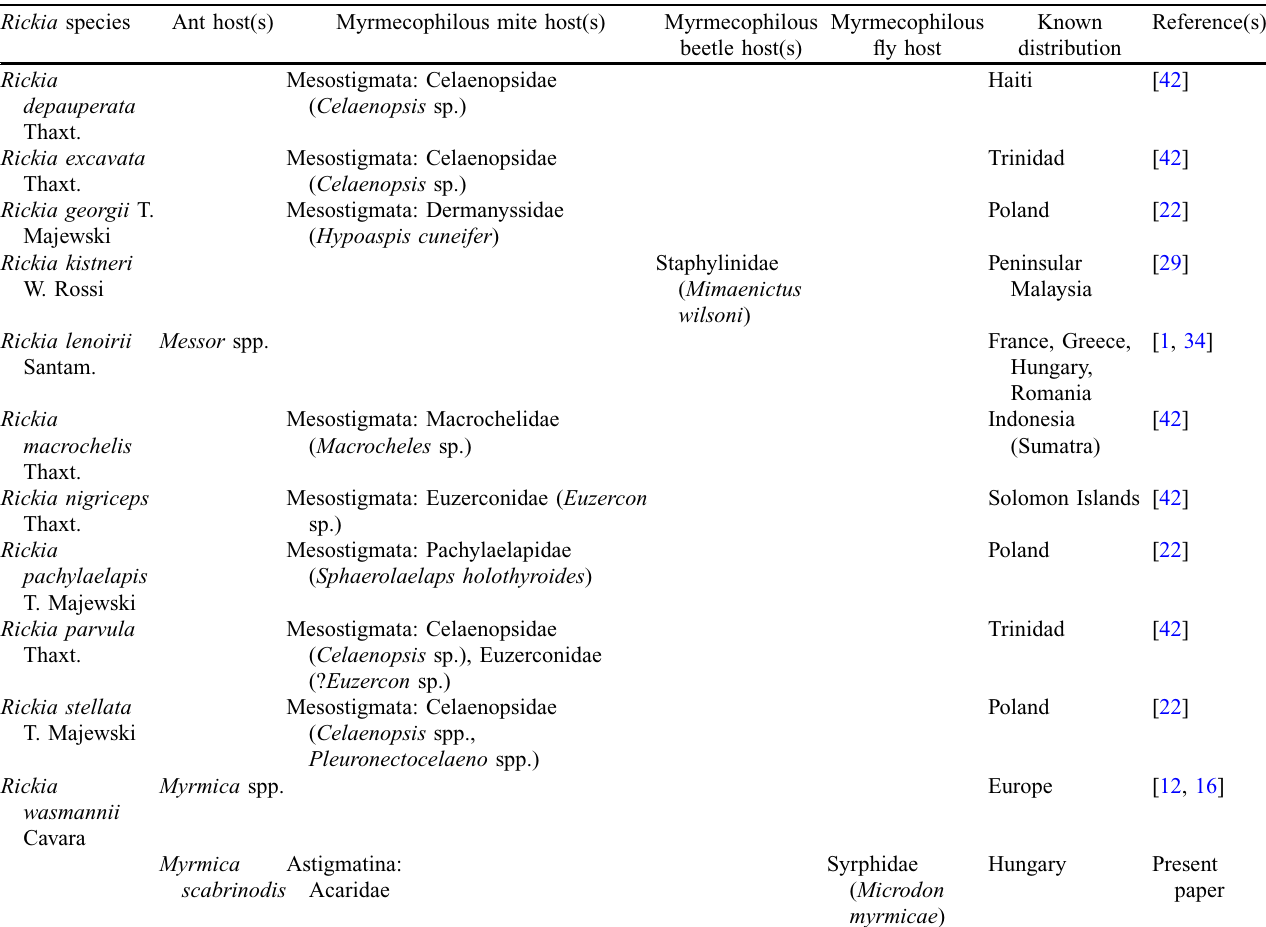
Table 2. Rickia parasitizing ants and/or associated (myrmecophilous) arthropods, with indication of the currently known